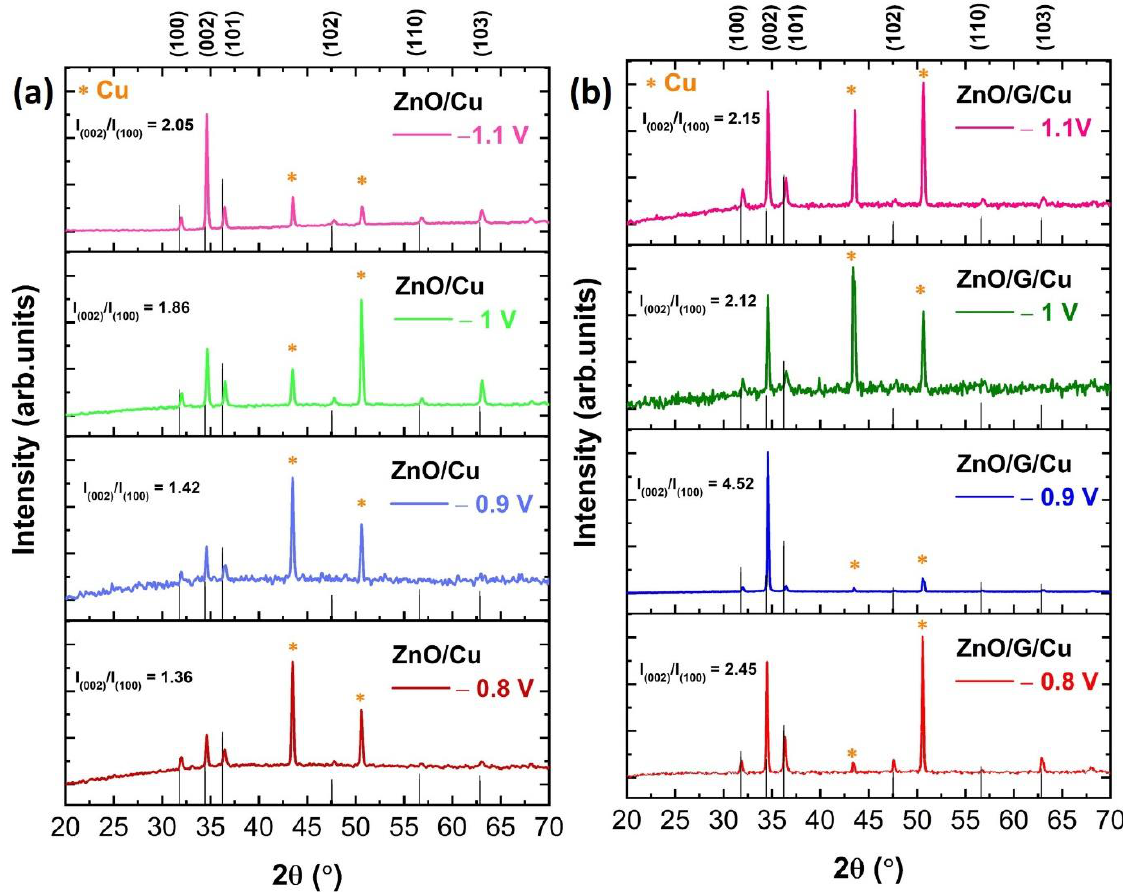
Figure 3. X-ray diffraction patterns of ( a ) ZnO/Cu and ( b ) ZnO/G/Cu electrodeposited at different applied potentials.